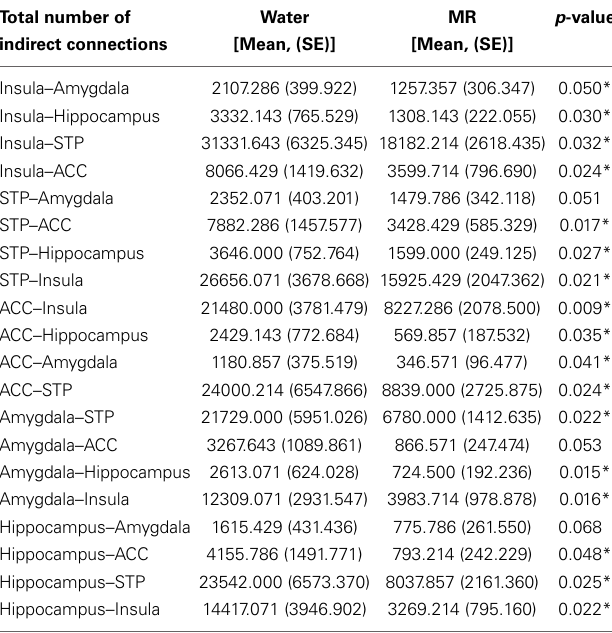
Table 3 | Summary of indirect connections between nodes of the